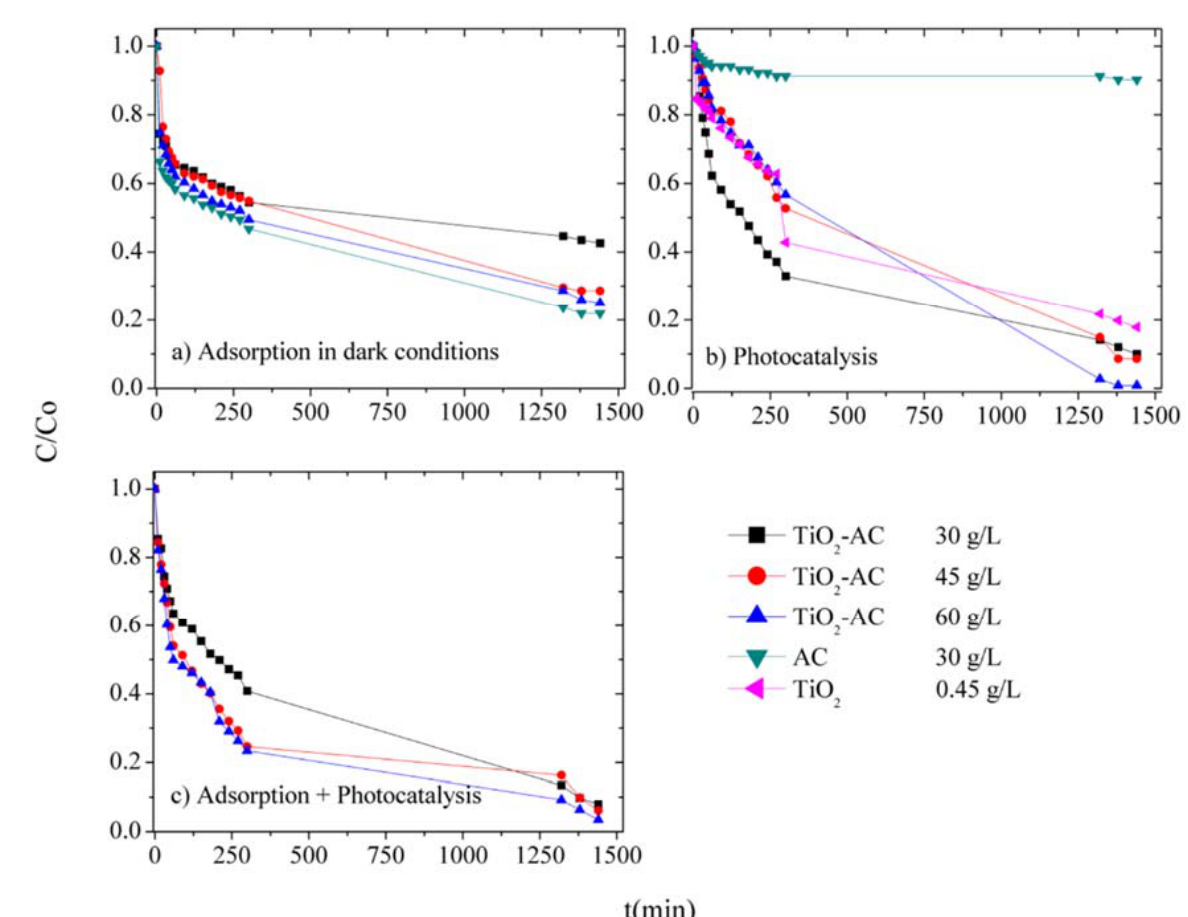
Figure 2. Cyanide ion degradation by ( a ) adsorption, ( b ) photocatalysis, and ( c ) simultaneous adsorption and photocatal ‐ ysis.